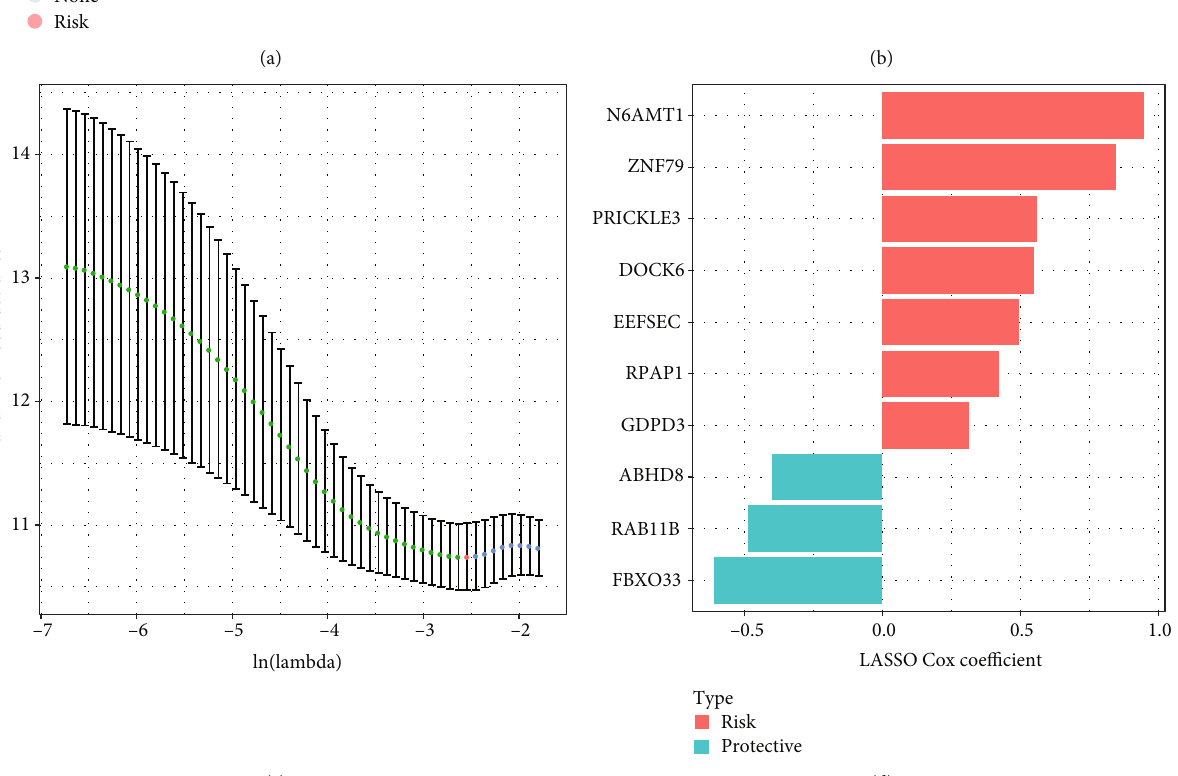
Figure 5: Identifying the genes related to necroptosis in the RNAseq data set. (a) Univariate regression between DEGs and TNBC prognosis. (b) LASSO coe ffi cient distribution regarding genes possessing prognostic value. (c) A 5 cross-validation was utilized for selecting the optimal parameters in the model. (d) The coe ffi cient of each gene in the optimal